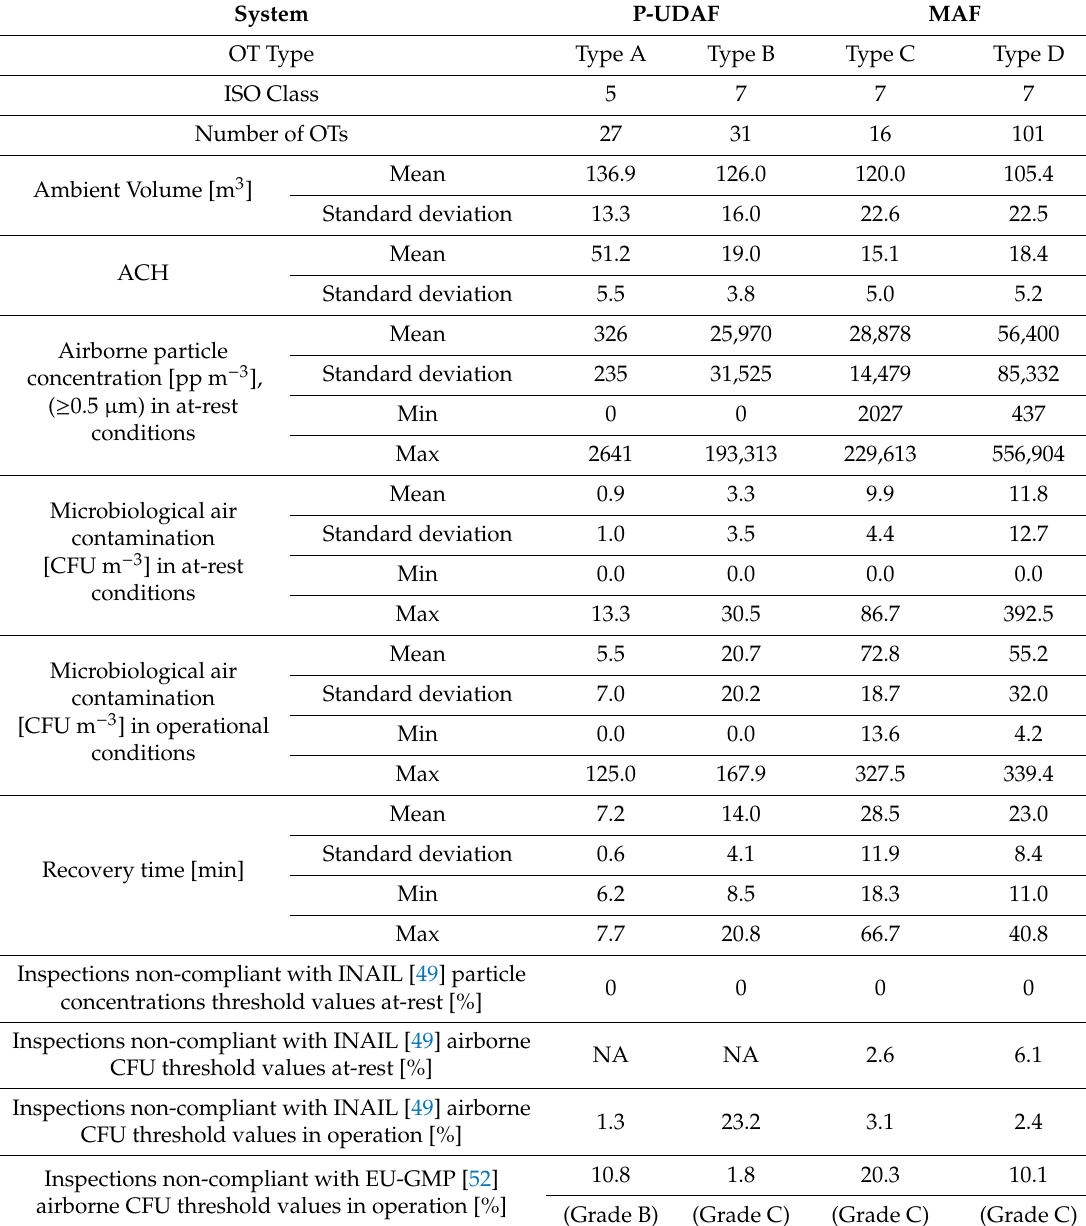
Table 4. Overview of the OTs and descriptive statistics of the measurement